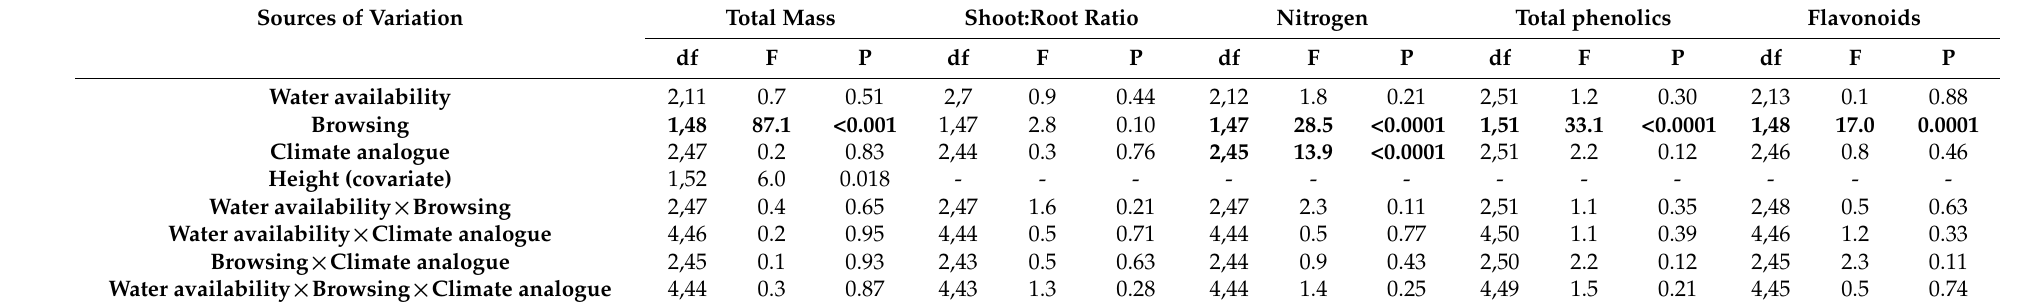
Table A5. ANOVA summary table for evaluating the effects of simulated winter browsing, water availability, seedling climate analogue (2018, 2050, 2080 analogues) and their interaction on white pine ( Pinus strobus L.) total mass, shoot:root ratio and chemical composition (nitrogen, total phenolics and flavonoids concentration). Seedlings were grown under different levels of water availability during a ten week greenhouse